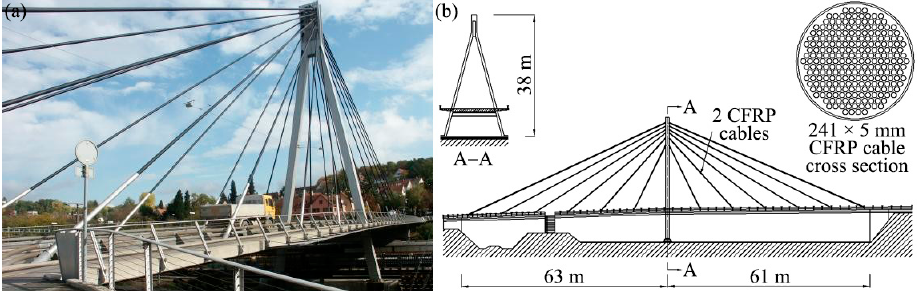
Figure 8. Stork Bridge, ( a ) photo (photo credit: EMPA) and ( b ) sketch.